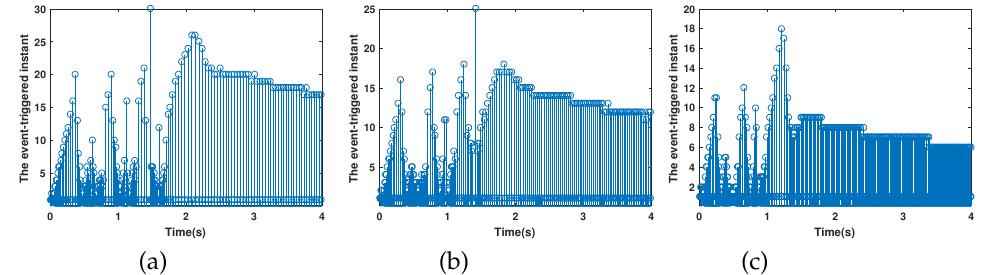
Figure 4. The event-triggered instant. ( a – c ) denote the event-triggered instants for vehicle 1, 2 and